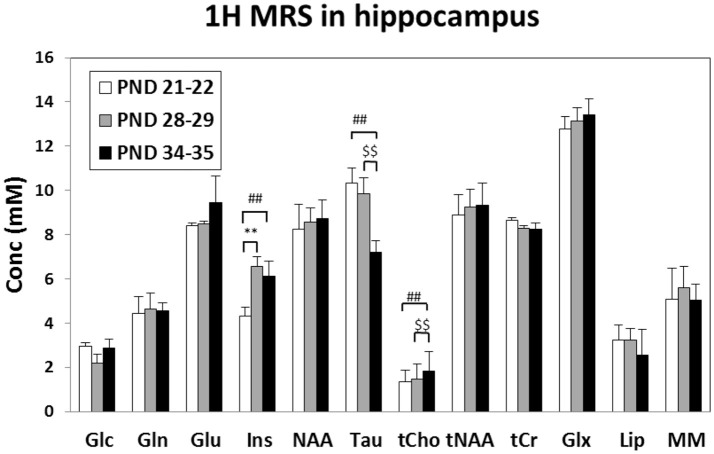
Metabolite concentrations (mM), corrected for water T2 and referred to water signal, measured in the rat Hip at “early” (PND 21–25), “mid” (PND 28–32) and “late” (PND 35–39) age stages in rats. **Early vs. mid p < 0.01 (juvenile transition); ##early vs. late p < 0.01; $$mid vs. late p < 0.01 (adolescent transitions). Metabolite assignments: Glc, glucose; Gln, glutamine; Glu, glutamate; Ins, inositol; NAA, N-acetyl-aspartate; Tau, taurine; tCho, total choline (phospho-choline plus glicero-phospho-choline); tNAA, total of NAA plus N-acetyl-aspartyl-glutamate; tCr, total creatine; Glx, total Gln+Glu; Lip, lipids at 1.3 ppm; MM, macromolecules.